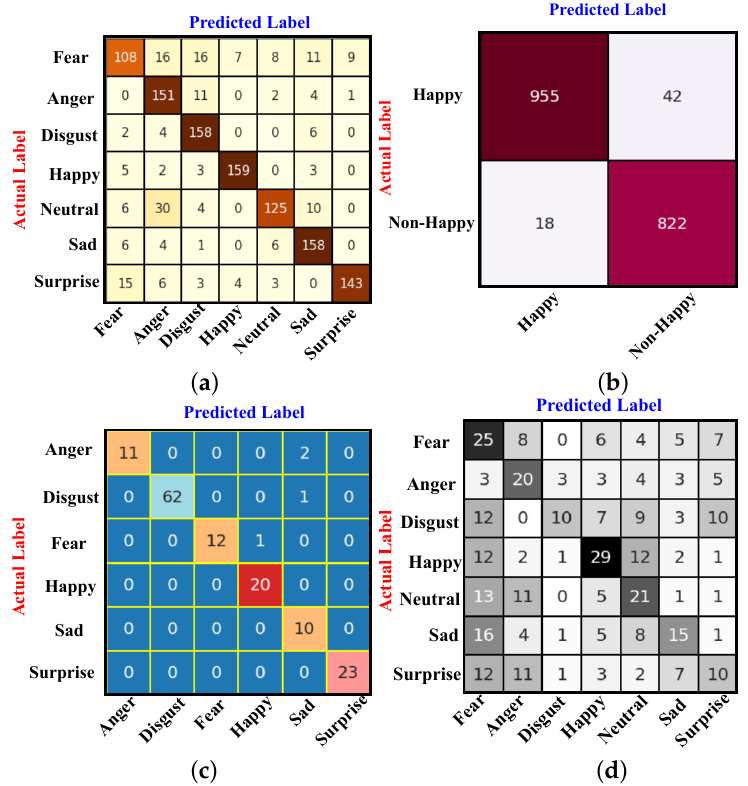
Table 10. The comparison of performance, as presented in Tables 7–10, shows the superior- ity of the proposed system.